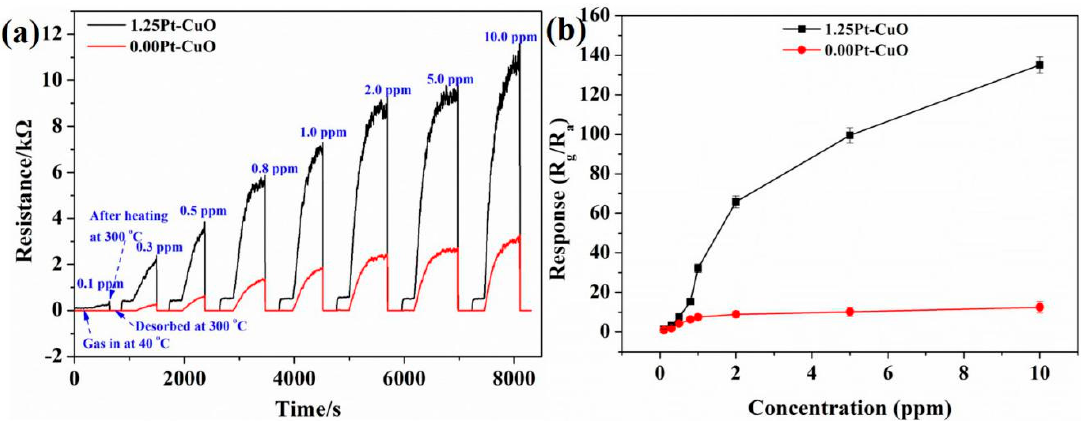
Figure 11. ( a ) Dynamic response transient of the gas sensor based on 1.25Pt-CuO and 1.00Pt-CuO to different concentrations of H 2 S gas at 40 °C; ( b ) gas response of 1.25Pt-CuO and 1.00Pt-CuO sensor to different concentrations of H 2 S at 40 °C.